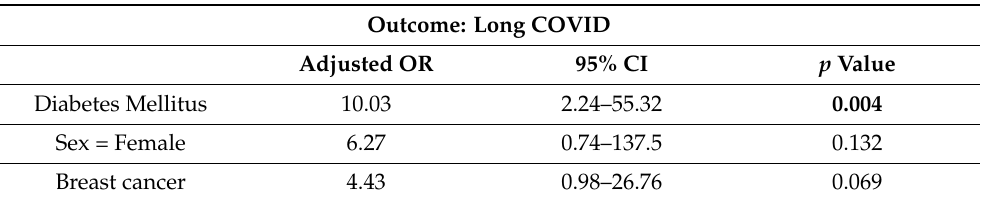
Table 3. Multivariable analysis: Logistic regression for assessing association between variables and long COVID.